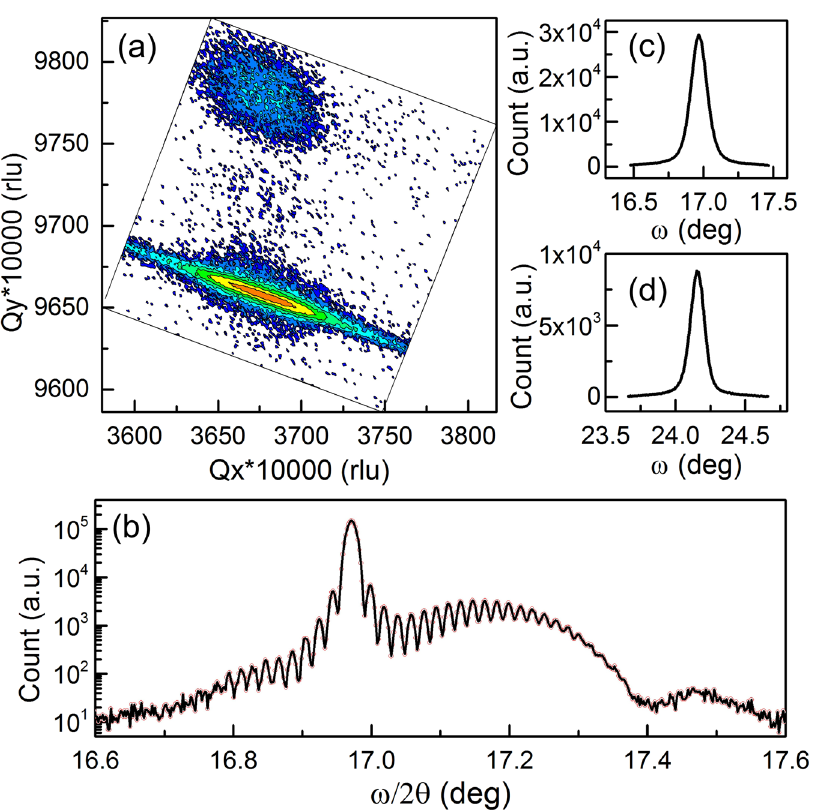
Figure 4. High resolution X-ray diffraction of DH NM on SiO 2 /Si. ( a ) The (105) reciprocal space mapping. ( b ) (002) ω /2 θ scan. ( c ) (002) rocking curve of GaN. ( d ) (102) rocking curve of GaN.